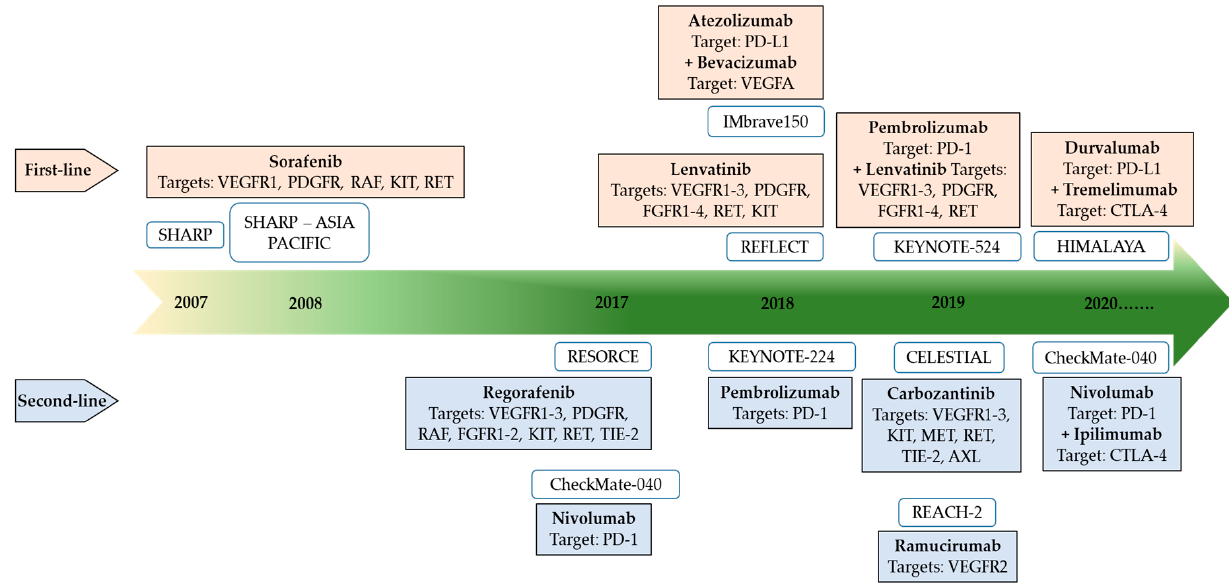
Figure 5. Overview of the key systemic agents approved for management of HCC. Figure adapted from Huang A et al., STTT2021 [87]. AXL; tyrosine protein kinase receptor UFO; CTLA, cytotoxic T-lymphocyte antigen; FGFR, fibroblast growth factor receptor; KIT, proto-oncogene, receptor tyro- sine kinase; MET, mesenchymal-epithelial transition factor; PD-L1, programmed cell-death ligand-1; PDGFR, platelet-derived growth factor receptor; RAF, rapidly accelerated fibrosarcoma; RET, rear- ranged during transfection; TIE-2, tyrosine protein kinase receptor Tie-2; VEGFR, vascular endothelial growth factor receptor.